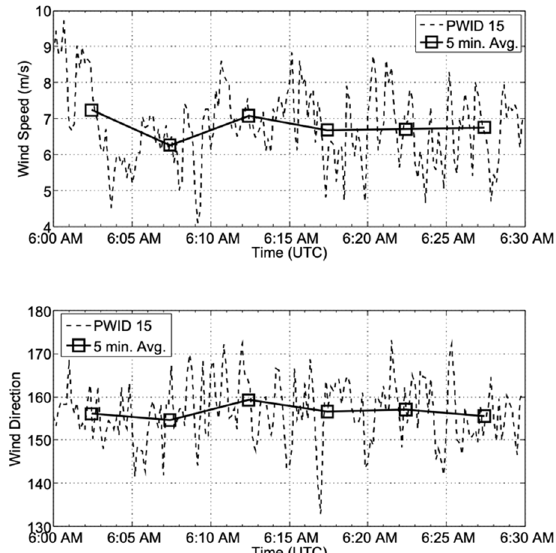
Figure 7. Five minutes of averaged data from PWID 15 were used to build the inflow profiles for the Aeolus LES simulation.